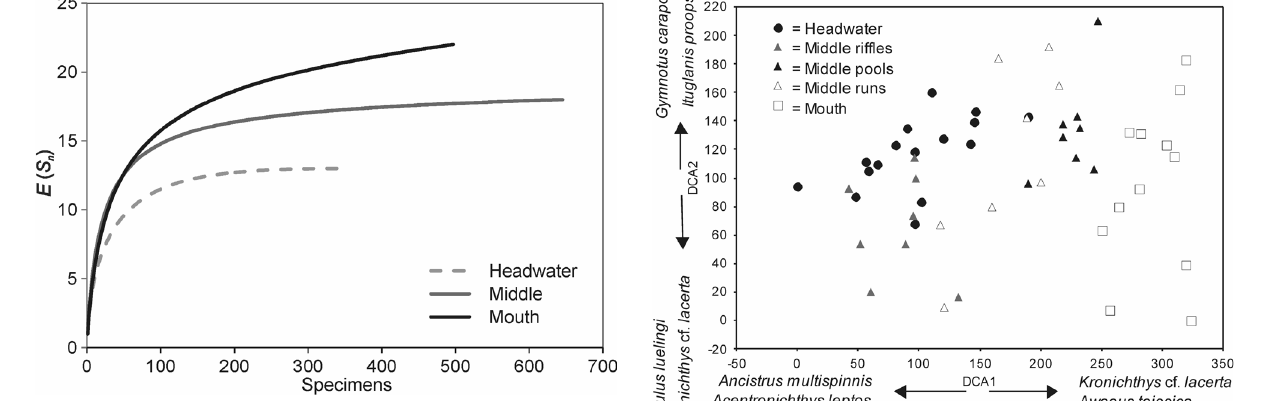
Figure 4. Species rarefaction curves for reaches in the Vermelho River, Paraná state, Brazil. E(S ) denotes the expected number of Figure 5. Ordination of the sampling sites through a detrended n species according to abundance. correspondence analysis (DCA) applied to the density matrix of fish species in the Vermelho River, Paraná state, Brazil.